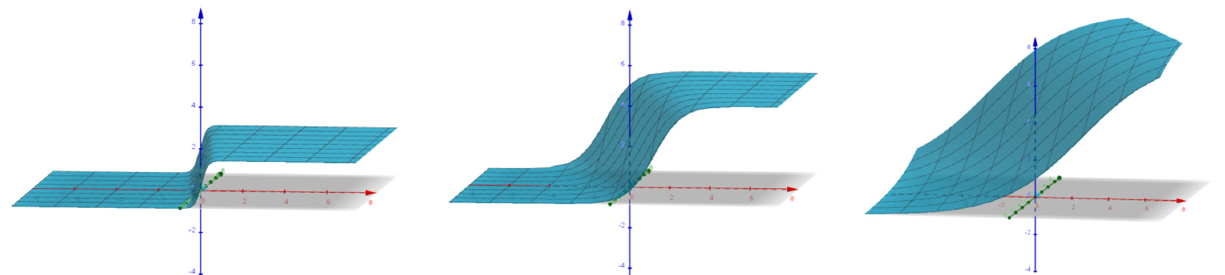
Figure 2. When n = 1, fix β = – 1.5 and take α as – 4.2, –1.5 and –0.5 respectively. For the travelling wave solutions of Equation (19), when n = 2, α = − 3, the corre- sponding graphs of β = − 4.6, − 1 and − 0.3 are given as follows (Figure 3):